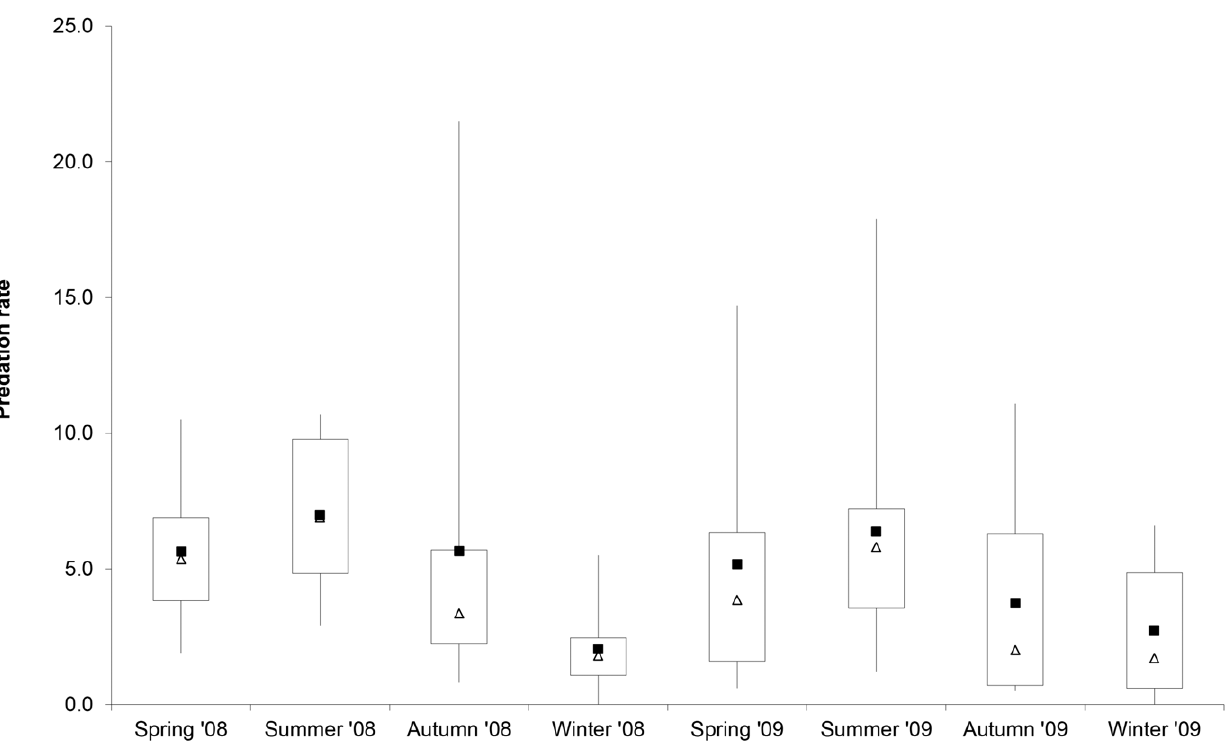
Figure 4. Boxplot of seasonal predation rates (prey cat 2 1 season 2 1 ). Means and medians are represented by solid squares and open triangles respectively: boxes denote inter-quartile ranges; lines denote minimum and maximum values. Sample sizes are: spring 2008, N=6 squares; summer 2008 to spring 2009, N=9; summer 2009 to winter 2009, N=12.